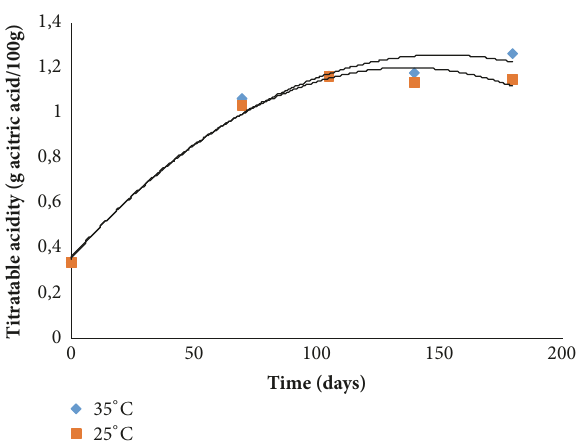
Figure 1: Titratable acidity behavior during storage.